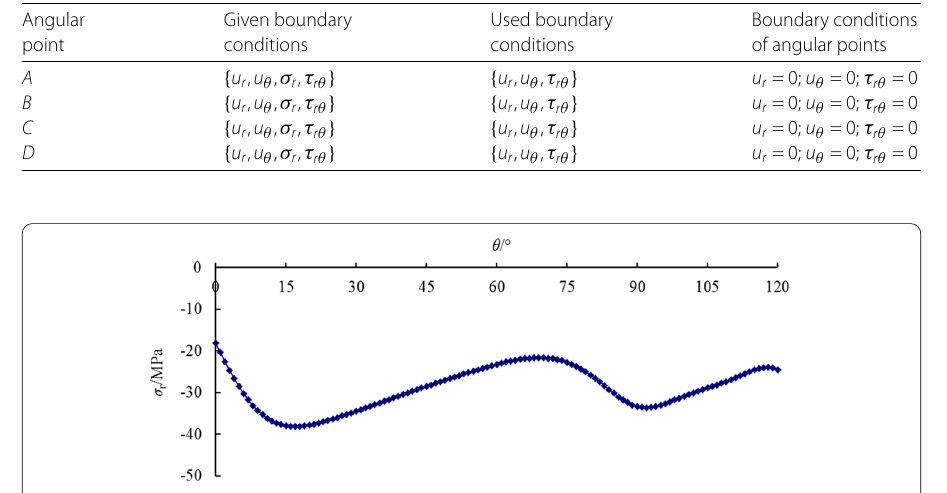
Table 2 Boundary conditions at four corners Angular point